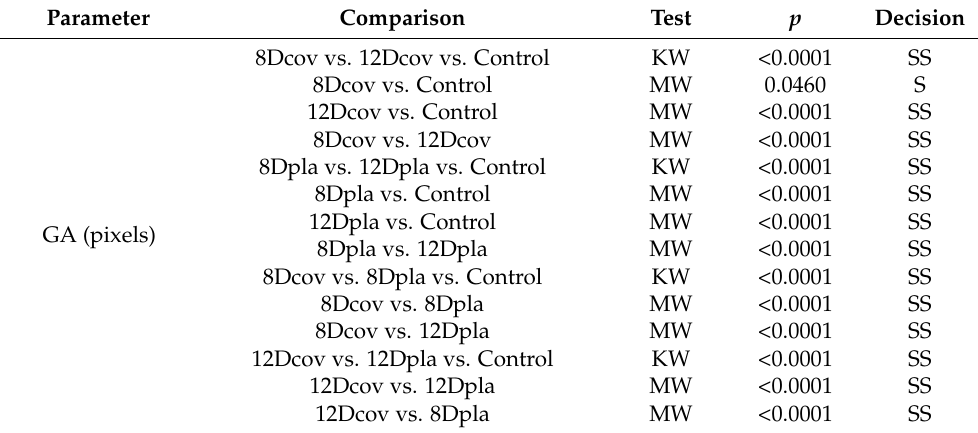
Table 2. Statistical comparison of birefringence average gray values (GA) between collagen bundles in rat tendons differently cultivated in